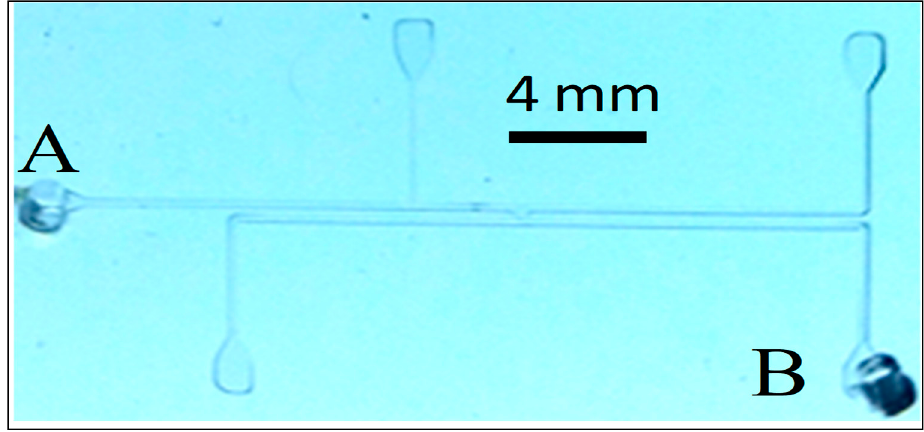
Figure 1. Microfluidics (MF) model used to conduct Lab on Chip assay. ( A ) Sample loading point; ( B ) Sample exit point after filling the MF channels completely.